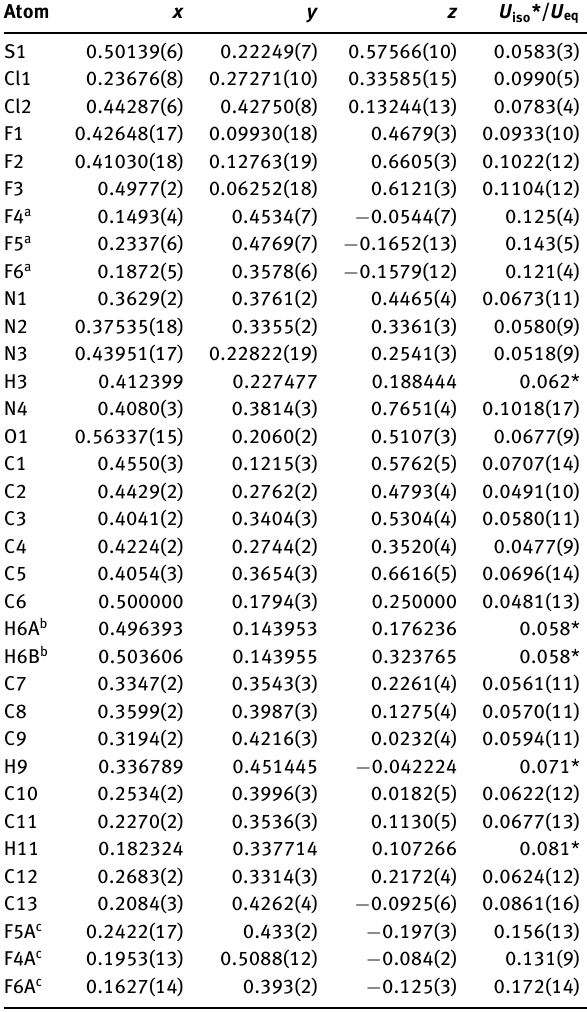
Table 2: Fractional atomic coordinates and isotropic or equivalent isotropic displacement parameters (Å 2